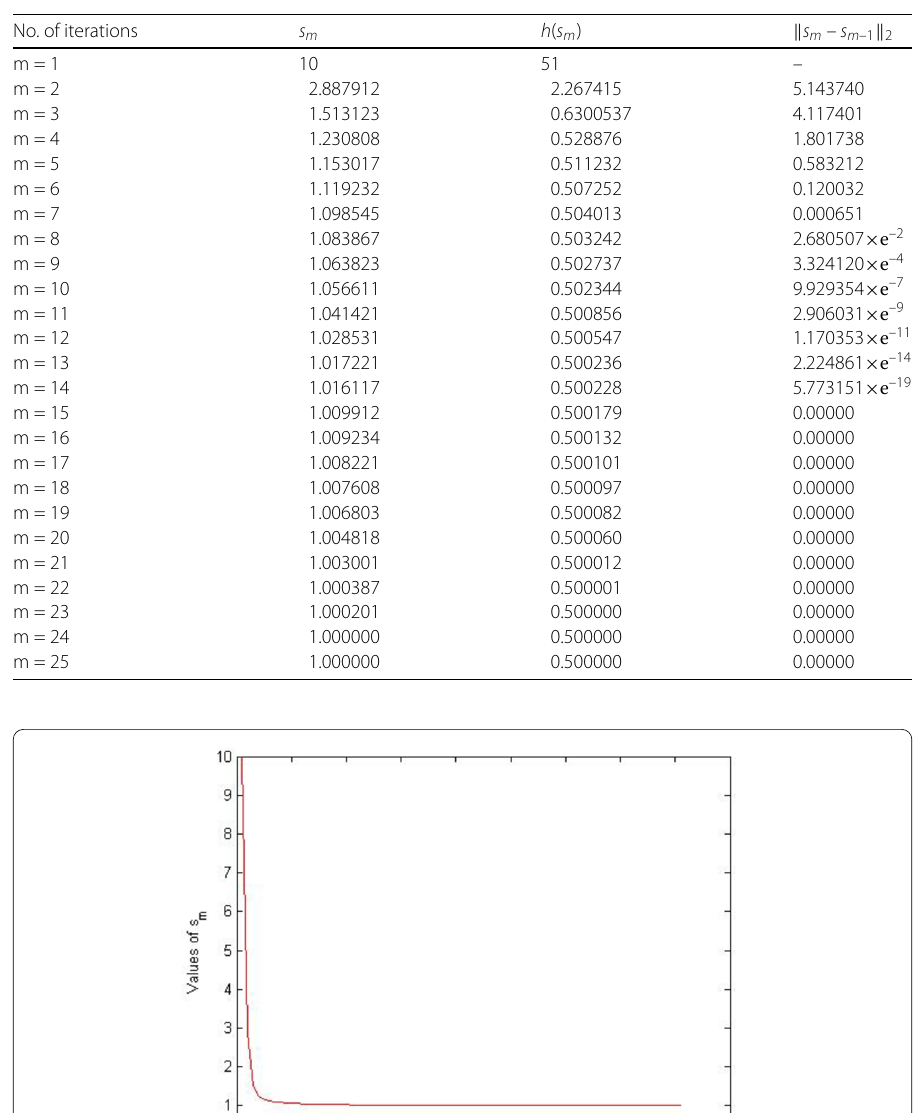
Table 1 Numerical values of s m and (cid:14) s m – s m –1 (cid:14) 2 No. of